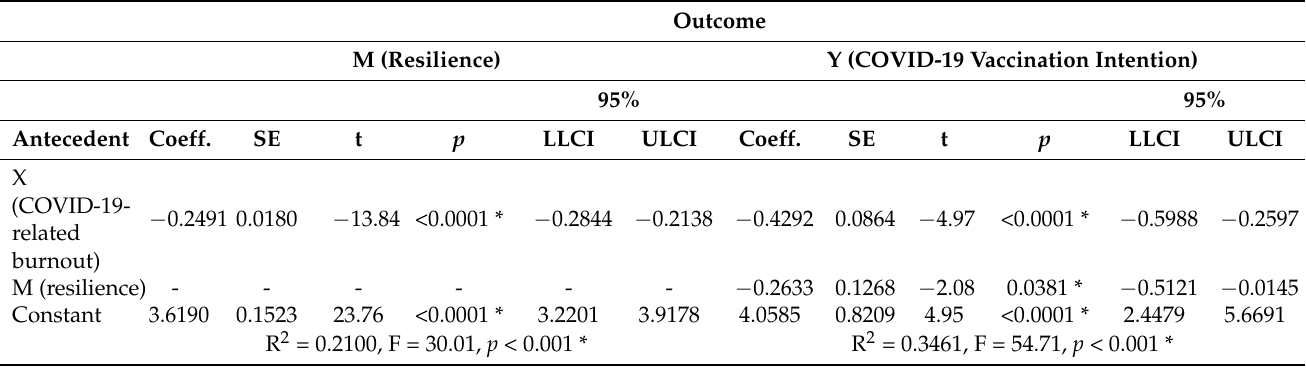
Table 5. Standardized total, indirect, and direct effects from confirmatory factor analysis on the